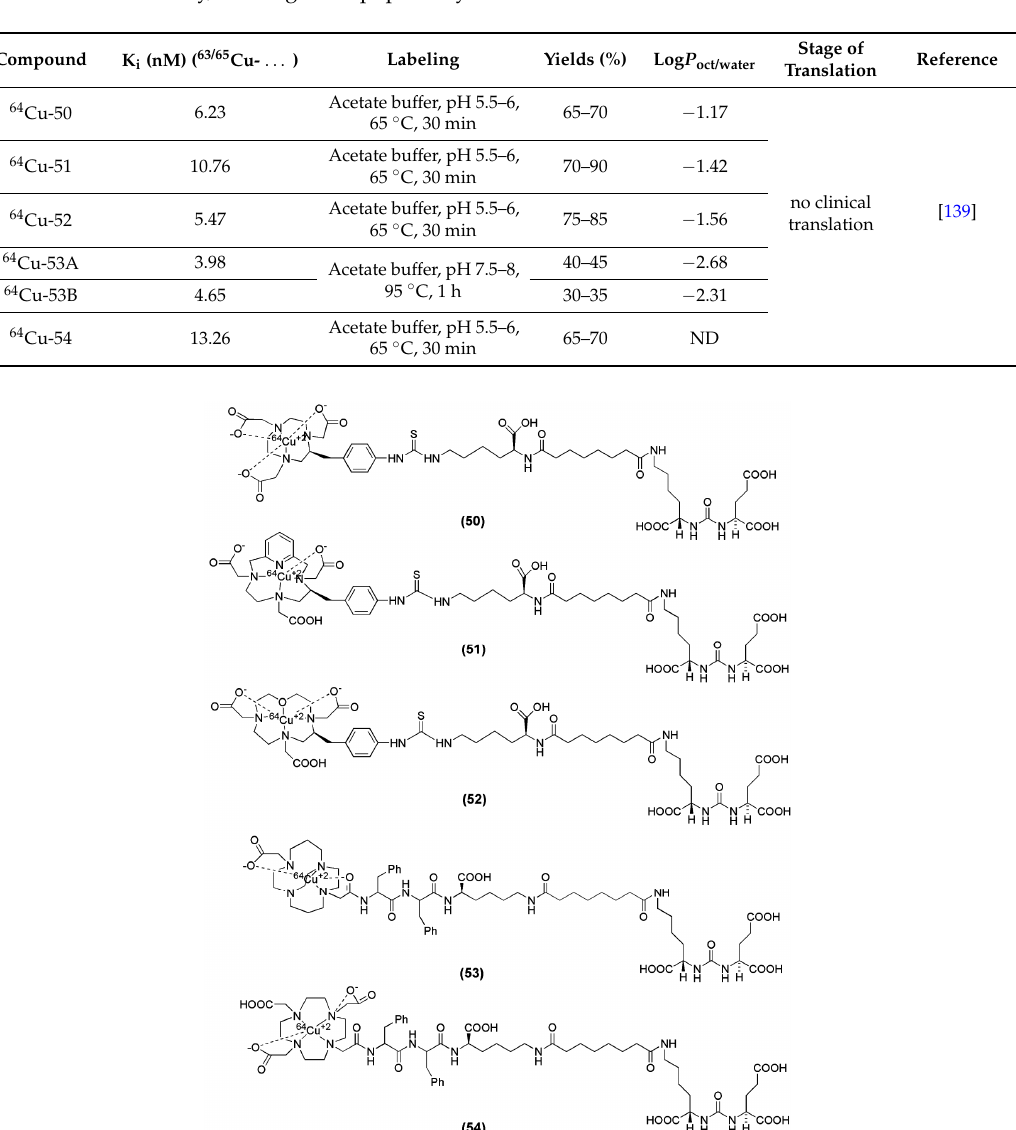
Table 6. Affinity, labeling and lipophilicity data of the 64 Cu-labeled PSMA inhibitors 50 – 54 .